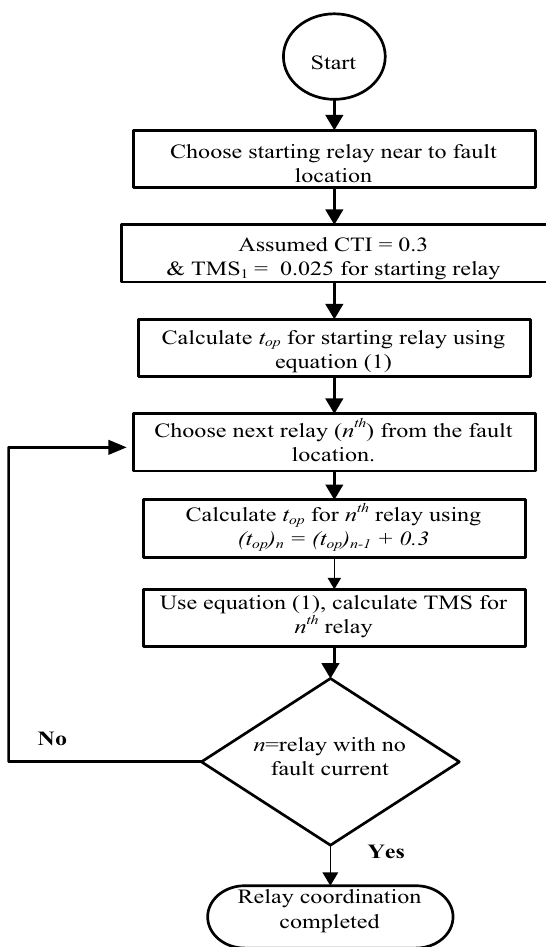
Fig. 7 Flowchart for relay co-ordination with busbar splitting